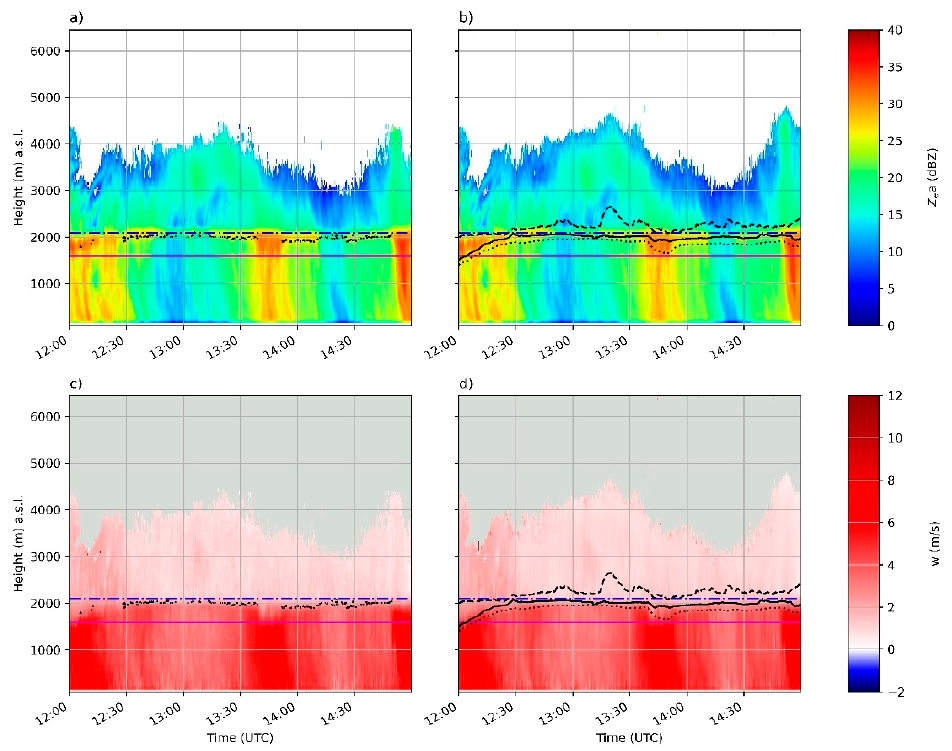
Figure 11. Time–height display of equivalent radar reflectivity—top row, panels ( a , b ) and Doppler velocity—bottom row, panels ( c , d ) calculated with the manufacturer’s software (first column) and RaProM- Pro (second column). First and second column show, respectively, the melting level detected by the manufacturer (black dots) and the BB top, BB peak and BB bottom (dashed, continuous, and dotted black lines). The data corresponds to 31 March 2020.